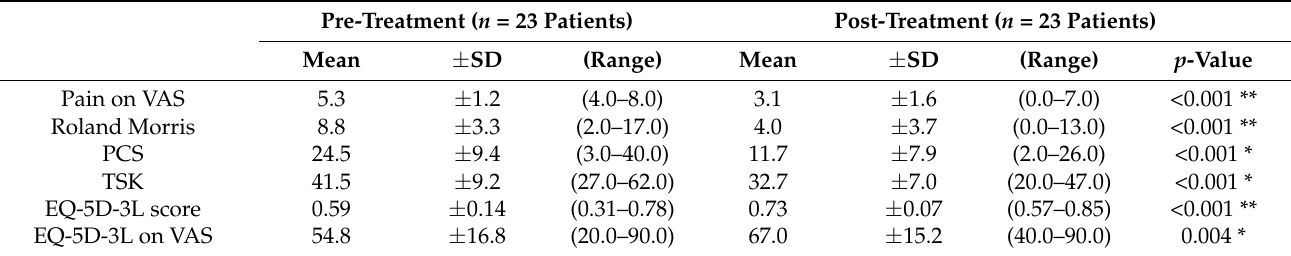
Table 2. Pre- and post-treatment PROMs